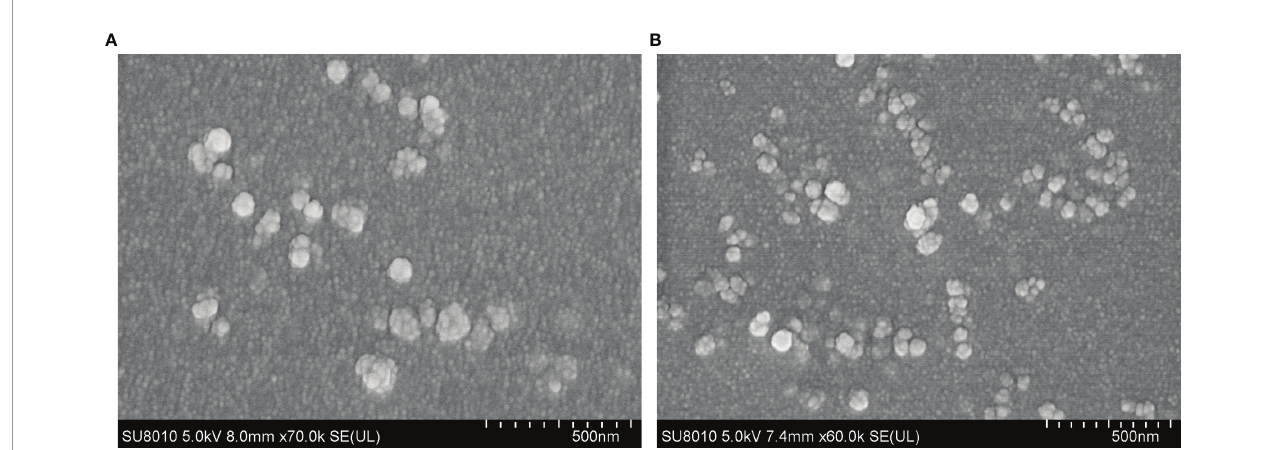
FIGURE 3 | Characterization of Em1a-PLGA (A) and Em1a-CS (B) nanospheres. Evaluated using SEM, Em1a-PLGA nanospheres were prepared with double emulsion solvent evaporation technique, while the Em1a-CS nanospheres were synthesized by the ionic technique. Bar represented 500